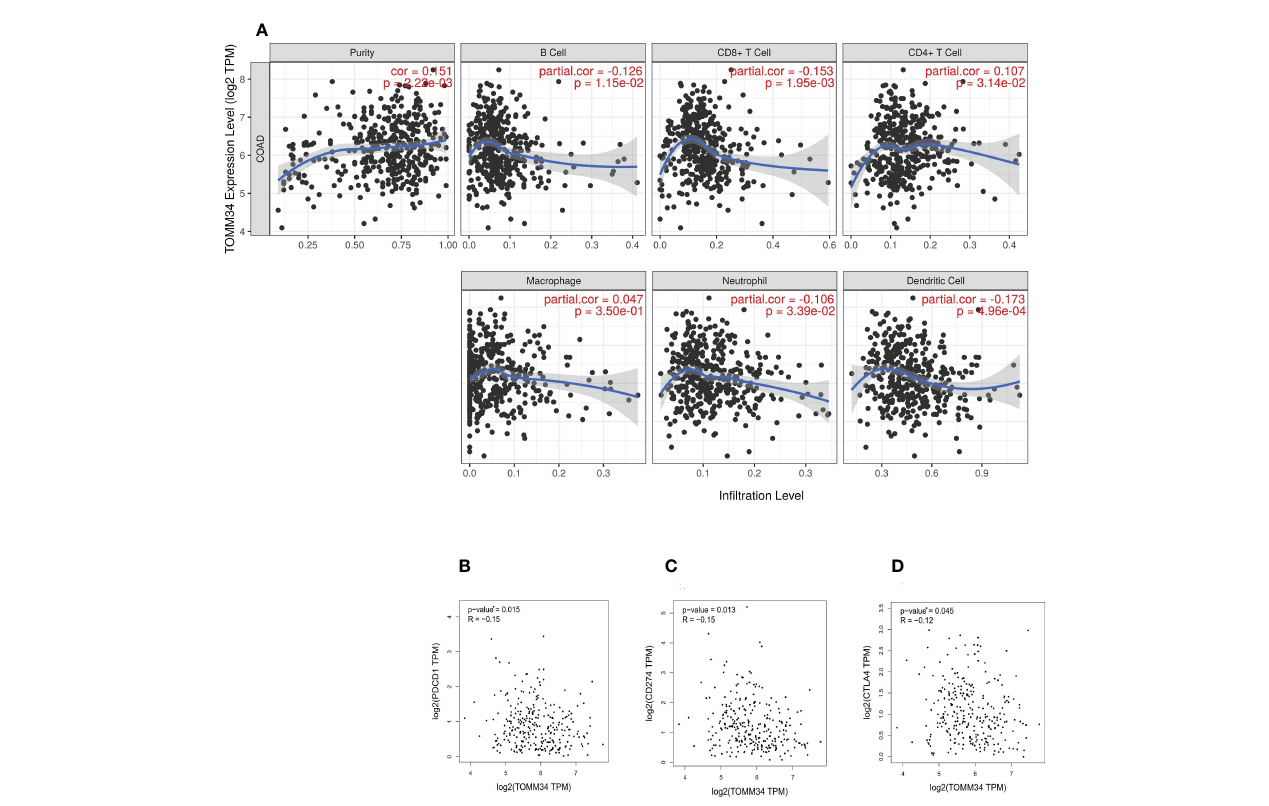
FIGURE 5 Correlation between TOMM34 expression and immune cell in fi ltration level. (A) The correlation between TOMM34 expression and distinct immune cell in fi ltration by using the TIMER database, revealing that TOMM34 expression was positively associated with the in fi ltration of CD4+ T cells and was not correlated with macrophages in colon cancer. (B) Correlations between TOMM34 expression and PD-1, indicating that TOMM34 was negatively associated with PD-1. (C) Correlations between TOMM34 expression and PD-L1, indicating that TOMM34 was negatively associated with PD-L1. (D) Correlations between TOMM34 expression and CTLA-4, indicating that TOMM34 was negatively associated with